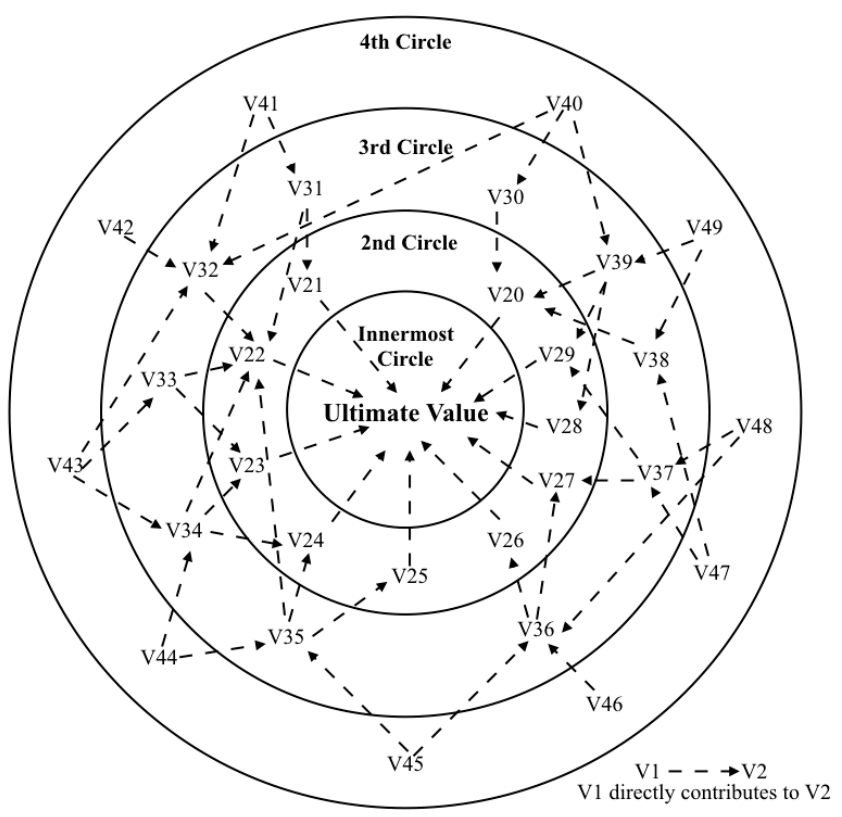
Figure 2. An example of a 4-circle CVC model.